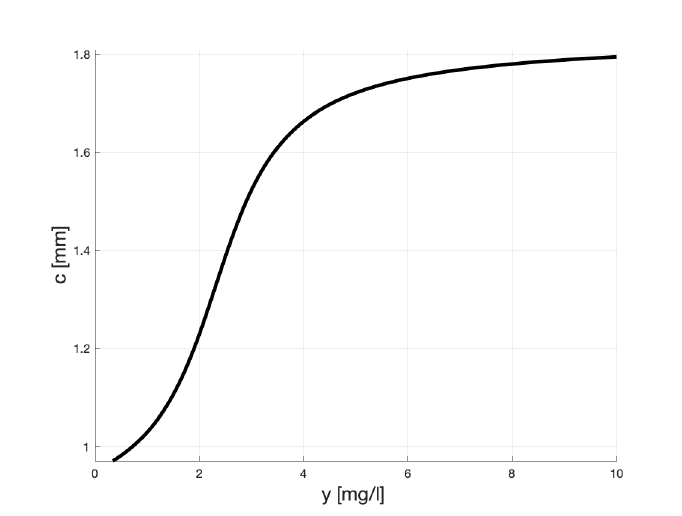
Figure 2. Possible relationship between y (hsCRP) and c for non-medicated